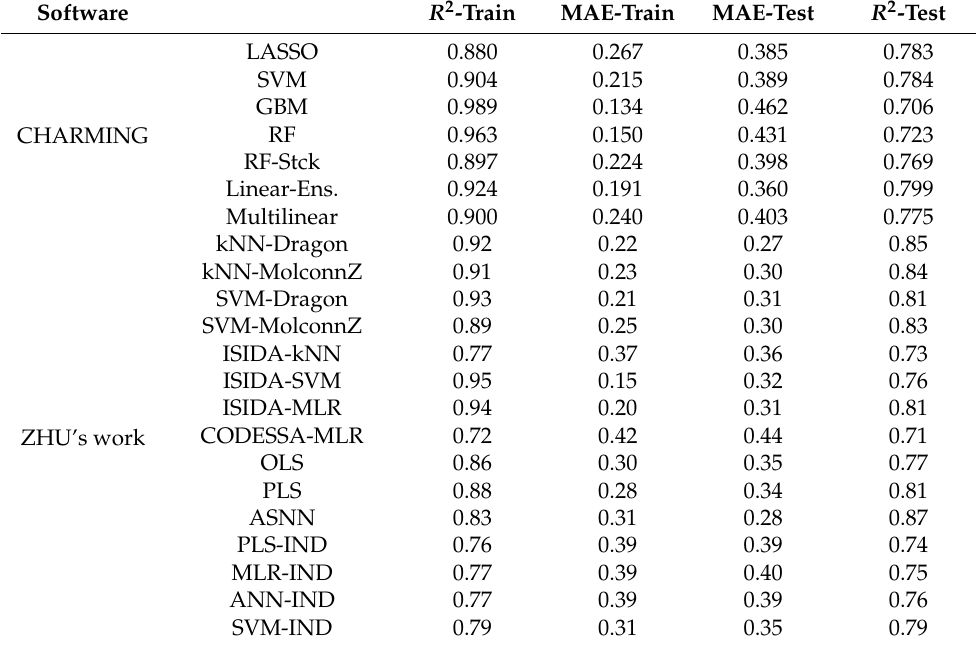
Table 1. Statistical parameters calculated for each model in the prediction of the biological activity (pIGC50) against T. pyriform using Least Absolute Shrinkage and Selection Operator (LASSO) as a feature selector for molecular fragments with different modeling strategies. In this case, the comparison uses Zhu’s work [39]. For further details see Supplementary files. Software R 2